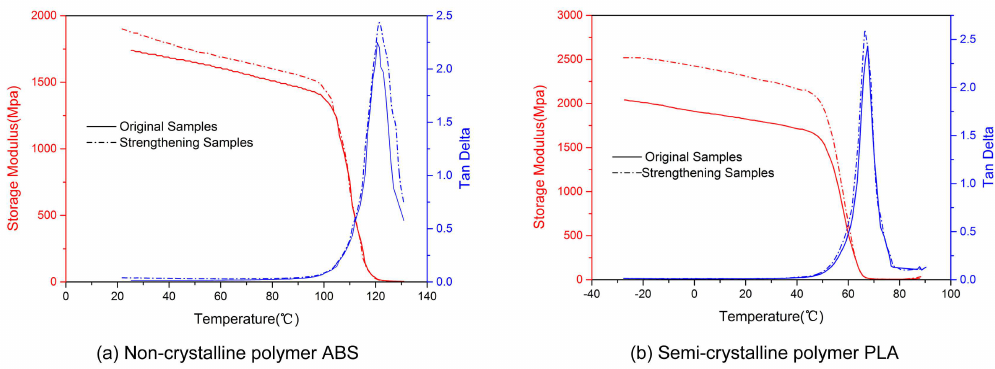
Figure 6. Storage modulus and loss tangent as a function of temperature for the original and ultrasonic-strengthened samples: non-crystalline polymer ABS ( a ); and semi-crystalline polymer PLA ( b ).